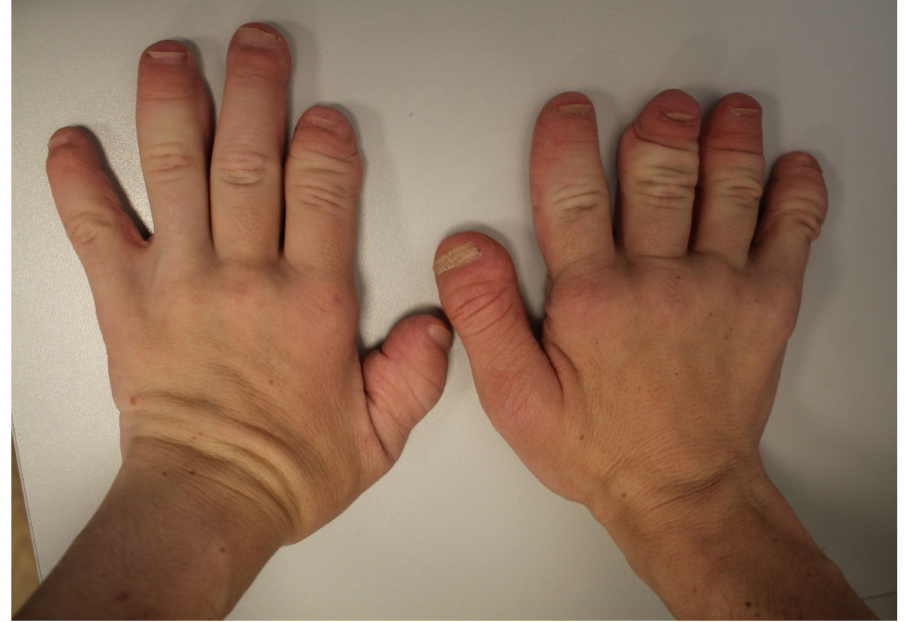
Figure 2. Short and thick fingers with